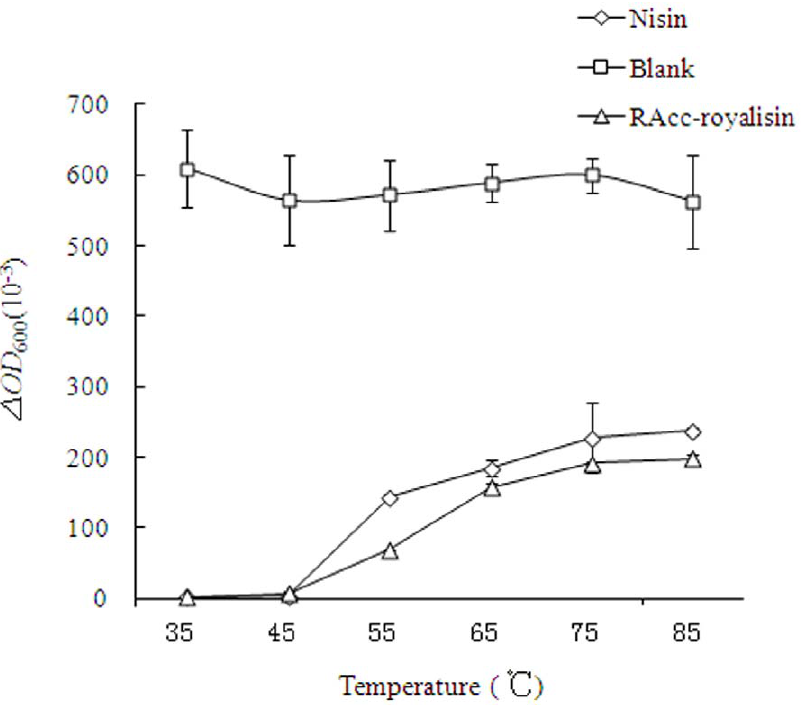
Figure 4. The effects of temperature on the antibacterial activity of RAcc-royalisin against B.subtilis . doi:10.1371/journal.pone.0047194.g004 PLOS ONE |